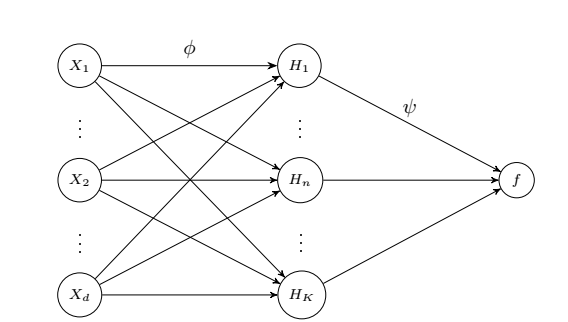
Figure 1. Feedforward neural network structure. Where X i , with i = 1, · · · , d represent the input nodes, H k , wit k = 1, · · · , K , the hidden nodes, f the output and the activation functions φ and ψ are as described in Equations (3) and (4),